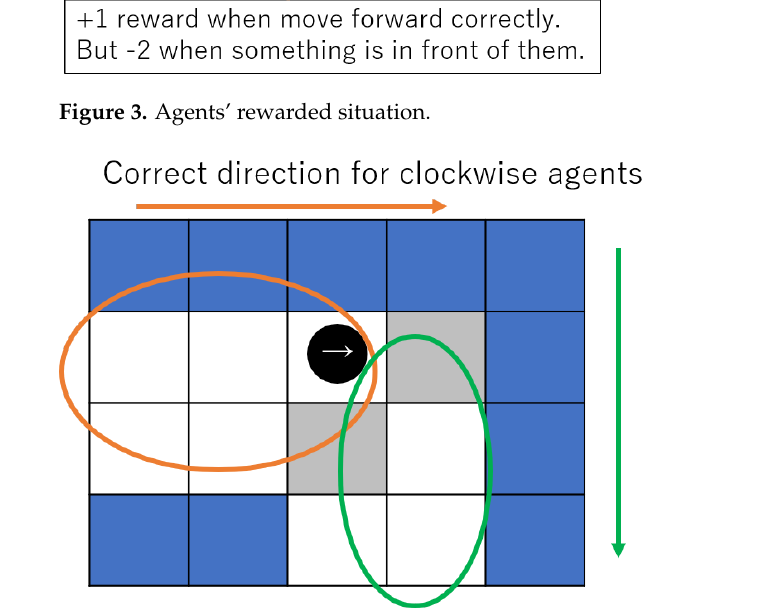
Figure 4. Correct direction for clockwise